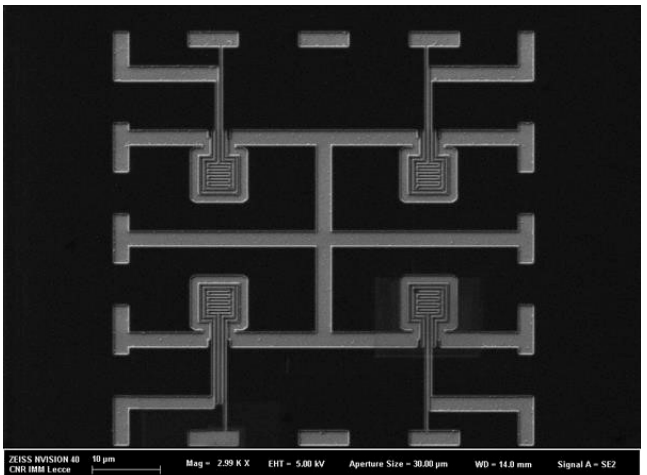
Figure 2. SEM image of an array of 4 nanogap sensor devices with embedded heater and thermometer. Best response sensor (ID8-1, 8V pp , 100 kHz AC field) exhibits about 1 order of magnitude response at 100 °C to 150 ppm of acetone, while the devices with fastest response times are the ID13-1 and ID13-3 (10V pp , 100 kHz AC field) (Figure 3).The fabricated nanogap devices allow a lower temperature operation of the gas sensors with reasonable response time; work is in progress to compare the responses of micrometric fingers gas sensors with the nanogap-based devices.